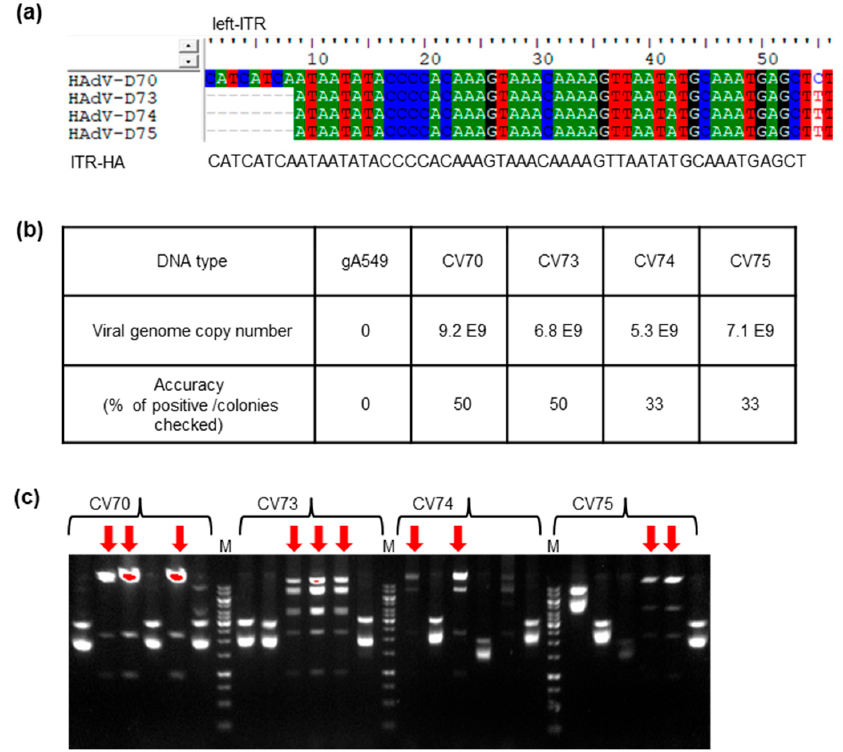
Figure 3. High-throughput cloning of new species D human adenoviruses (HAdV-D). ( a ) Identification of conserved sequences in the ends of inverted terminal repeats (ITR). Genome of conserved sequences in the ends of inverted terminal repeats (ITR). Genome sequences of